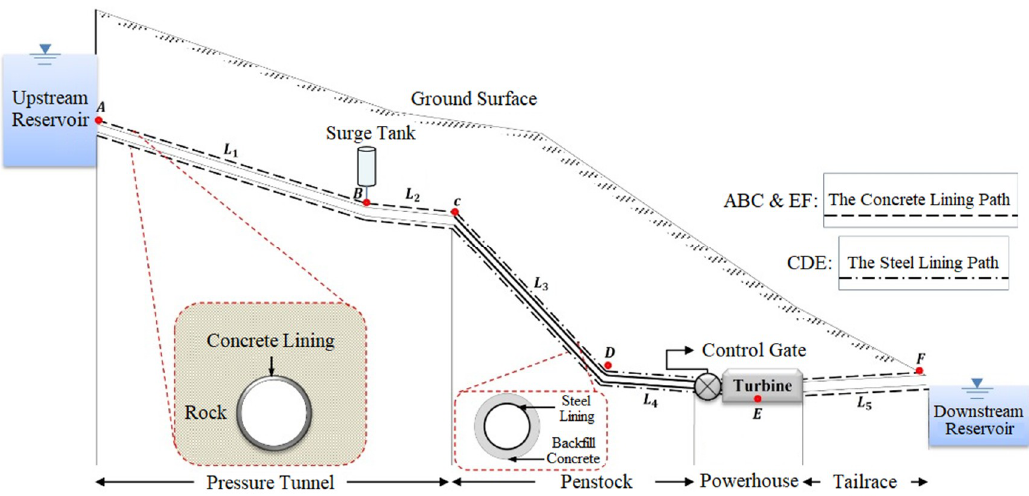
Figure 3. Simplified hydropower plan.